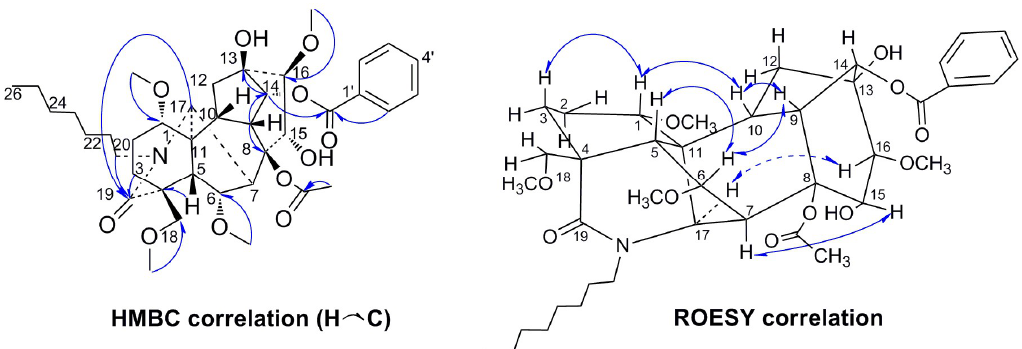
Figure 3. Key HMBC (H → C) and ROESY (H ↔ H) correlations of Compound 2 .